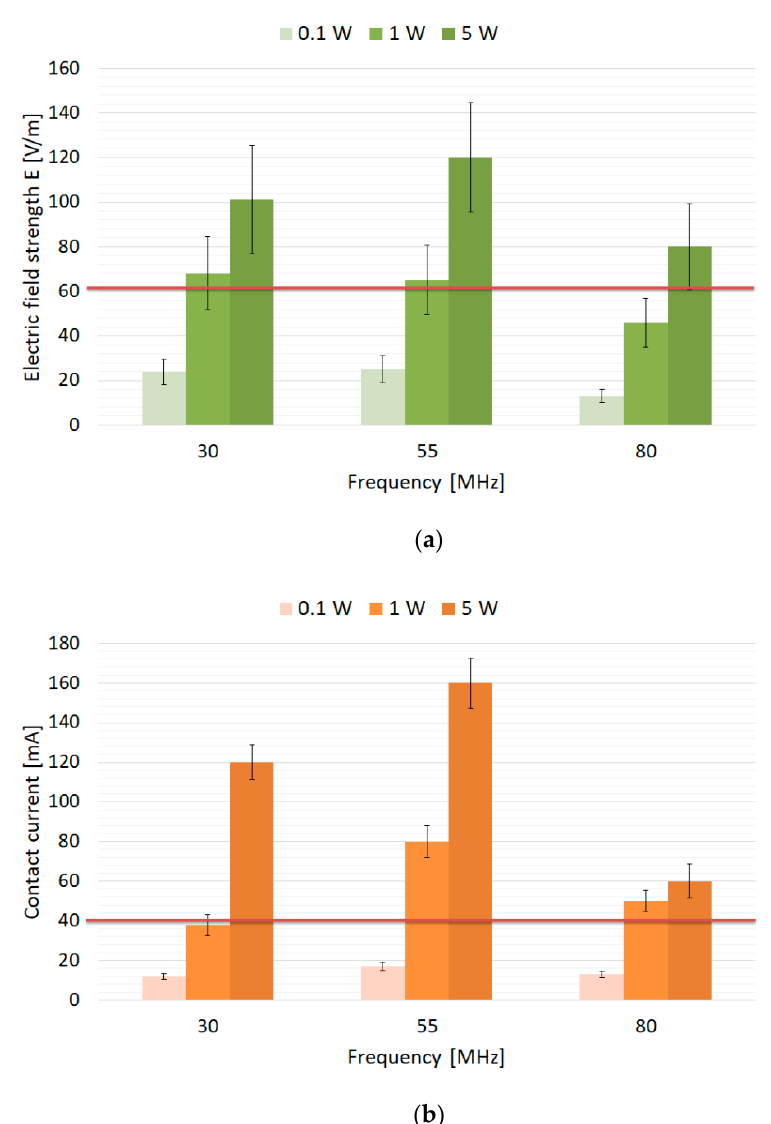
Figure 5. The results of the measurements of: ( a ) the electric field strength at a distance of 10 cm from the radiophone antenna; ( b ) the limb contact currents in the wrist of the hand holding the radiophone. The data are expressed as mean values ± standard error of the mean (SEM).